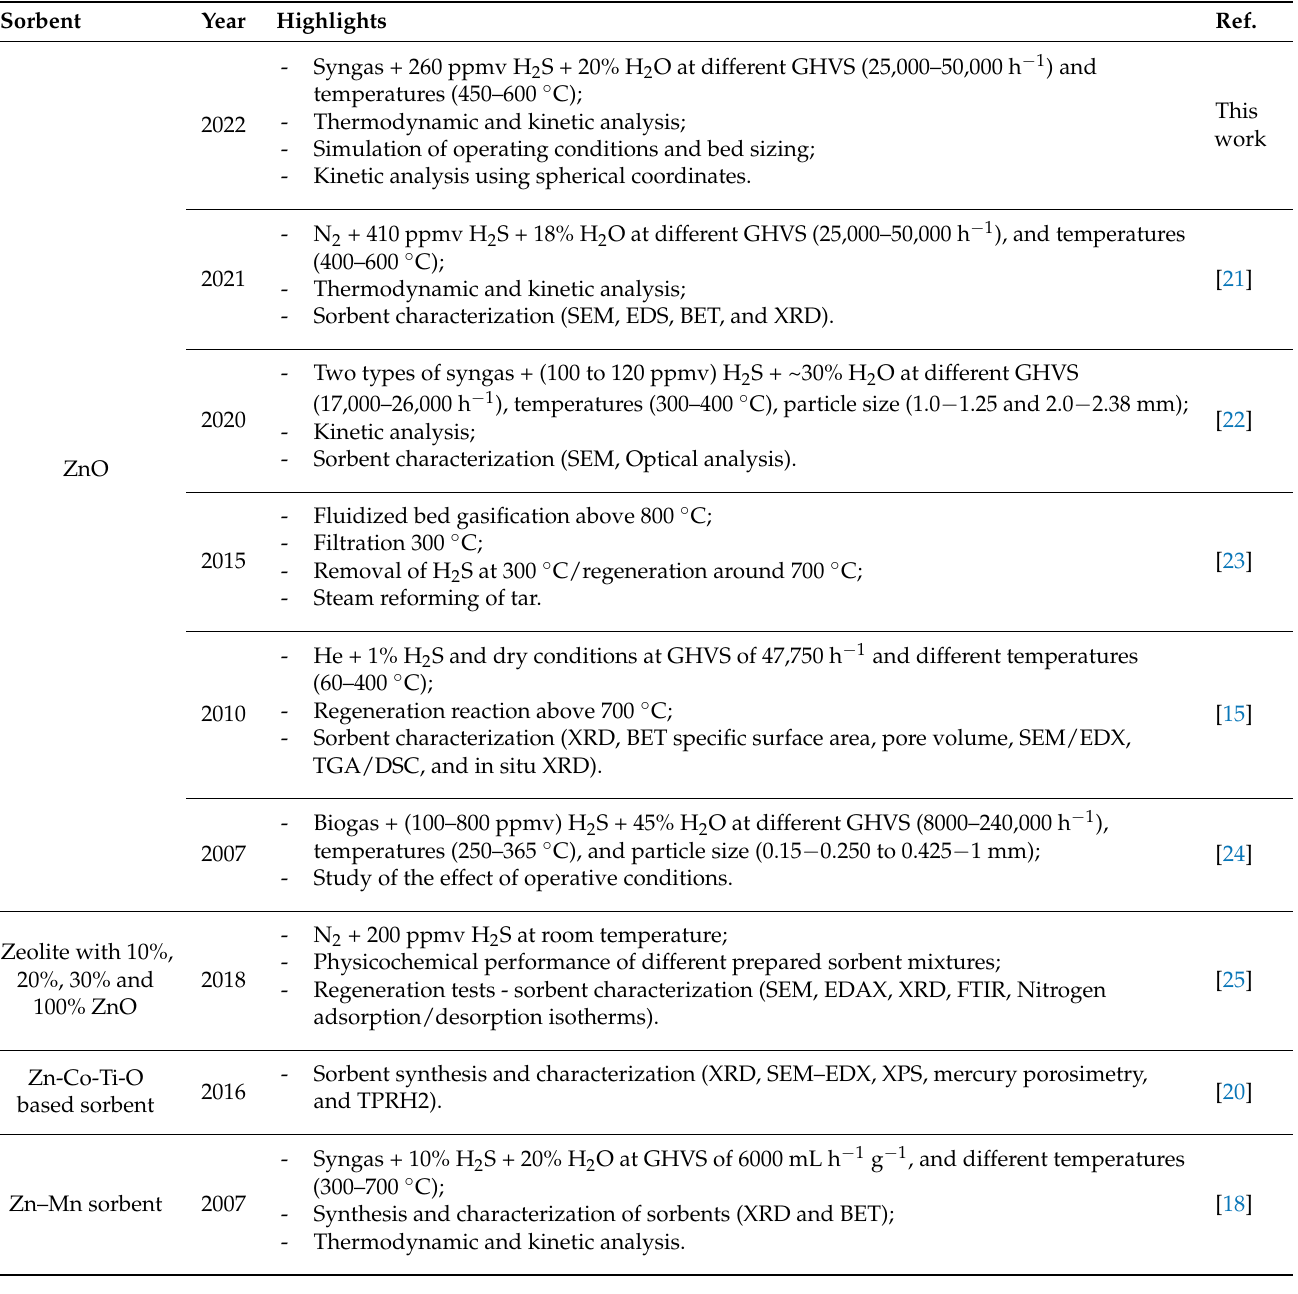
Table 1. Summary of the main contribution of the latest works on sulphur removal using ZnO- based